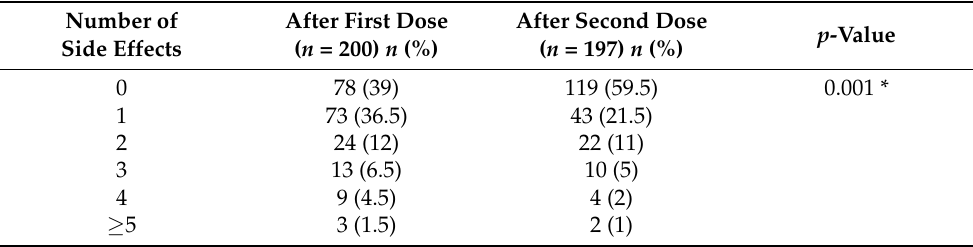
Table 4. Number of side effects in PAH/CTEPH patients after the first and second doses of vaccination against COVID-19.